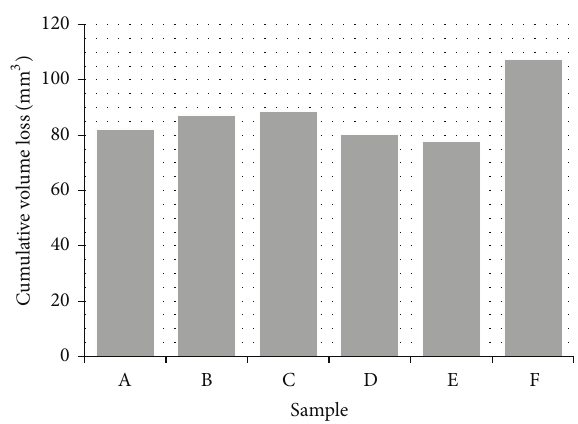
Figure 5: Percentage cumulative volume loss variation compared to sample